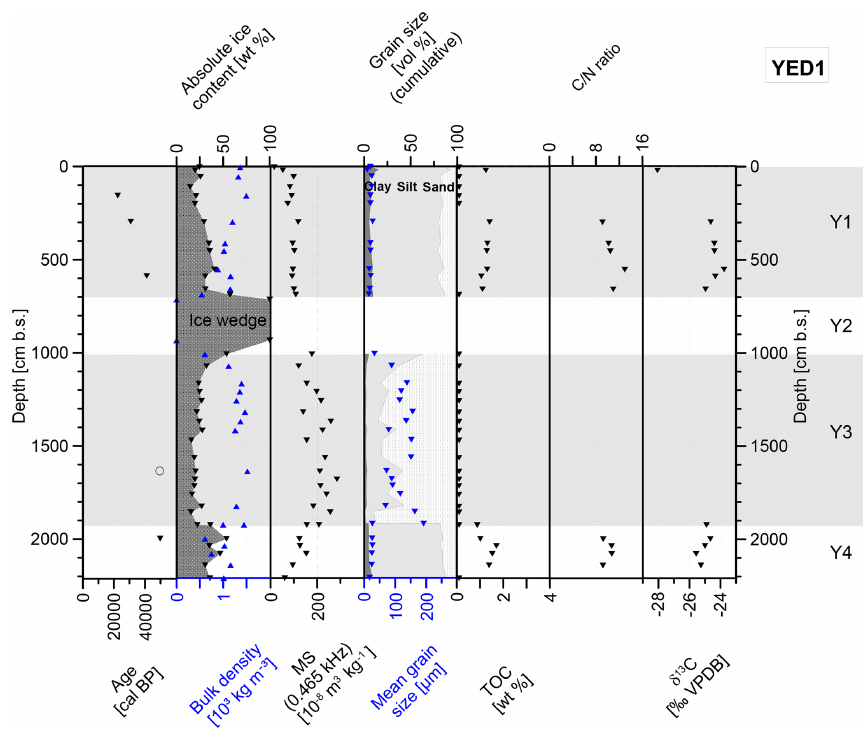
Figure 4. Characteristics of the Yedoma core YED 1: radiocarbon ages, absolute ice content, bulk density, magnetic susceptibility (MS), grain size composition, mean grain size, total organic carbon (TOC) content, carbon/nitrogen (C / N) ratio and stable carbon isotope ( δ 13 C) ratio. The hollow circle indicates an infinite radiocarbon (dead) age, and gray and white areas mark the different stratigraphic units (Y1 to Y4). Table 1. Radiocarbon measurement data and calibrated ages for the YED1 and Alas1 bulk organic material samples. Core Mean sample 14 C age ± F14C